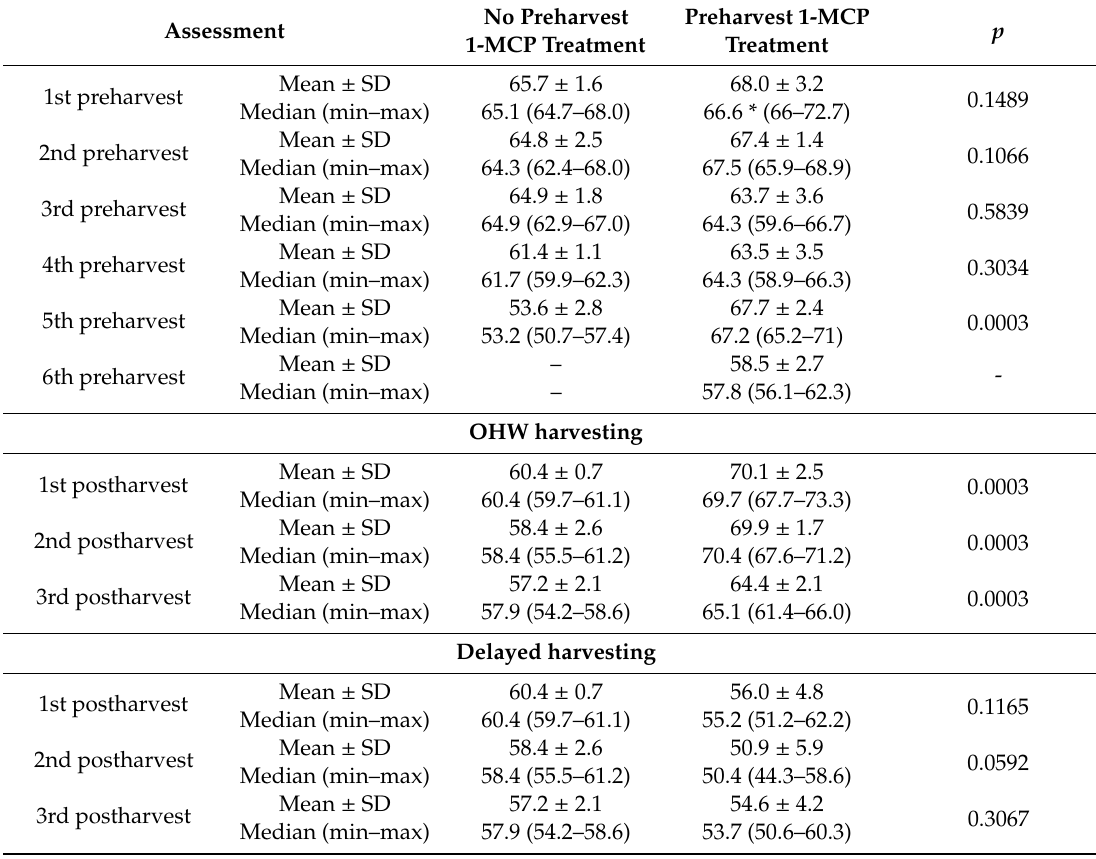
Table 2. Results for firmness [N] measured in ‘Szampion’ cultivar apples in the pre- and postharvest periods, compared for groups treated with 1-MCP and a control group not treated with